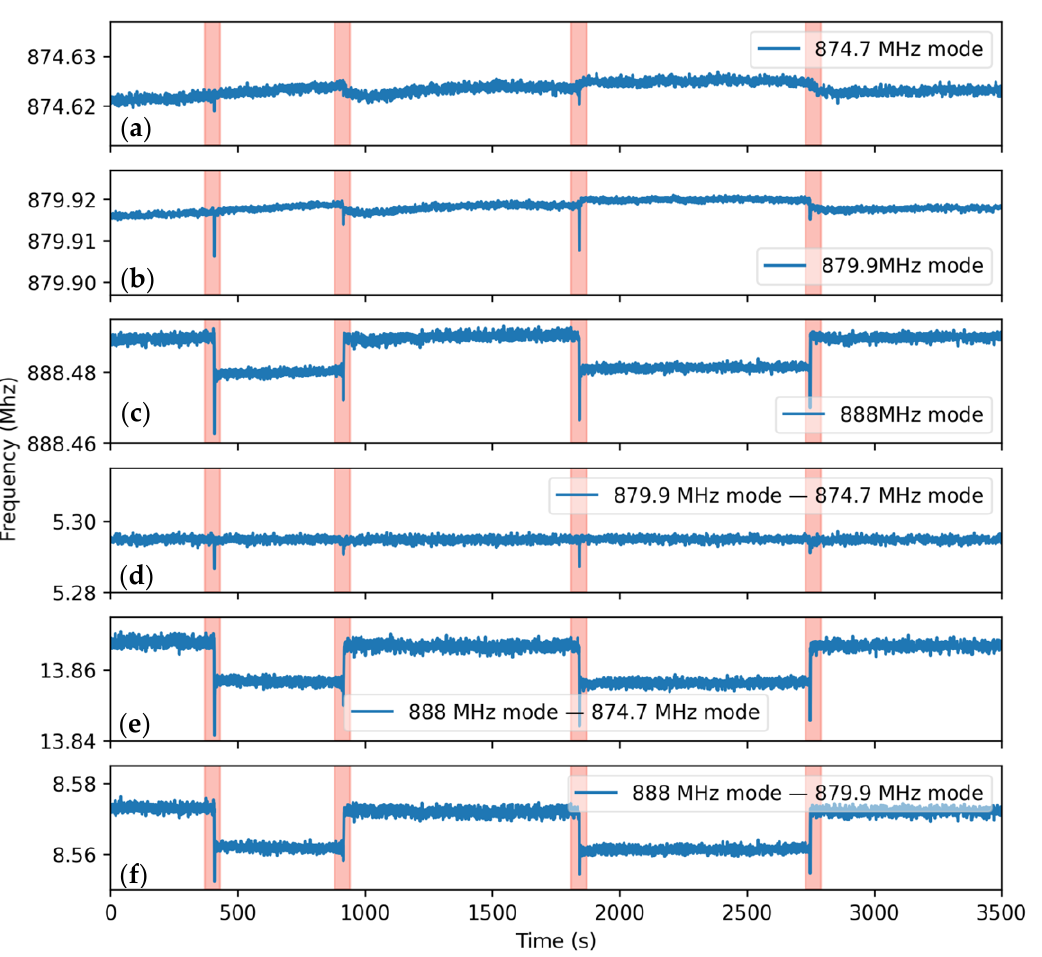
Figure 10. ( a – c ) Measured frequency corresponding to each of the sensor’s 3 resonance modes at 50 cm distance and peak and mean powers of 80 mW and 80 µW, respectively. The sensor was rotated by 90° (highlighted in red) to simulate the sudden rotation of the patient’s body. ( d ) For the 874.7 and 879.9 MHz modes, this frequency shift can be canceled by subtracting the 879.9 and 874.7 MHz modes, whilst the same compensation method was found to be ineffective between 888 and 879.9 MHz ( e ), 888 MHz, and 874.7 MHz ( f ).